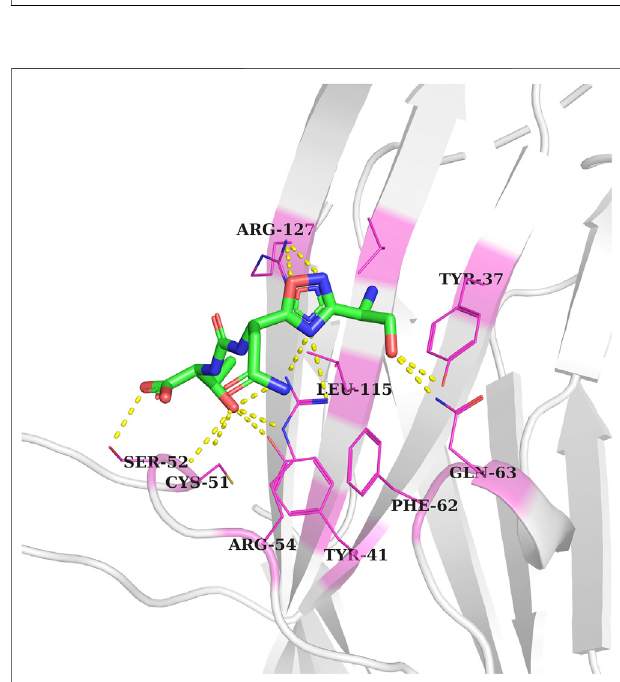
FIGURE 2 | Docked conformation of the CA-170 inhibitor in the VISTA active pocket (gray color). Interacting residue of VISTA is shown as pink- colored lines-cartoons and labeled. Meanwhile, hydrogen bonding between residues is represented by yellow-colored dotted lines.